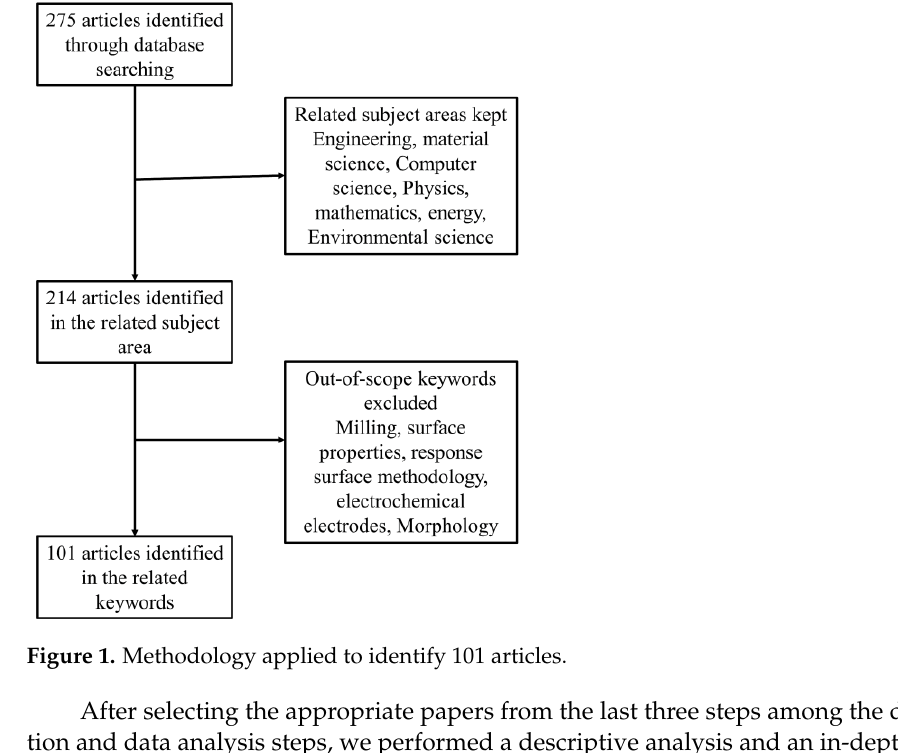
Figure 3. Distribution of the publications from 2015 to 2021 according to Scopus search results . Figure 4 illustrates the types of reviewed scientific documents. Almost 90% of the documents are scientific articles or conference papers. The studied books account for 2% and review papers account for 5% of the reviewed documents. Figure 5 shows the areas of these studies. Most areas refer to engineering, materials science, physics, and computer science. Figure 4. Document types of the publications according to Scopus search results .